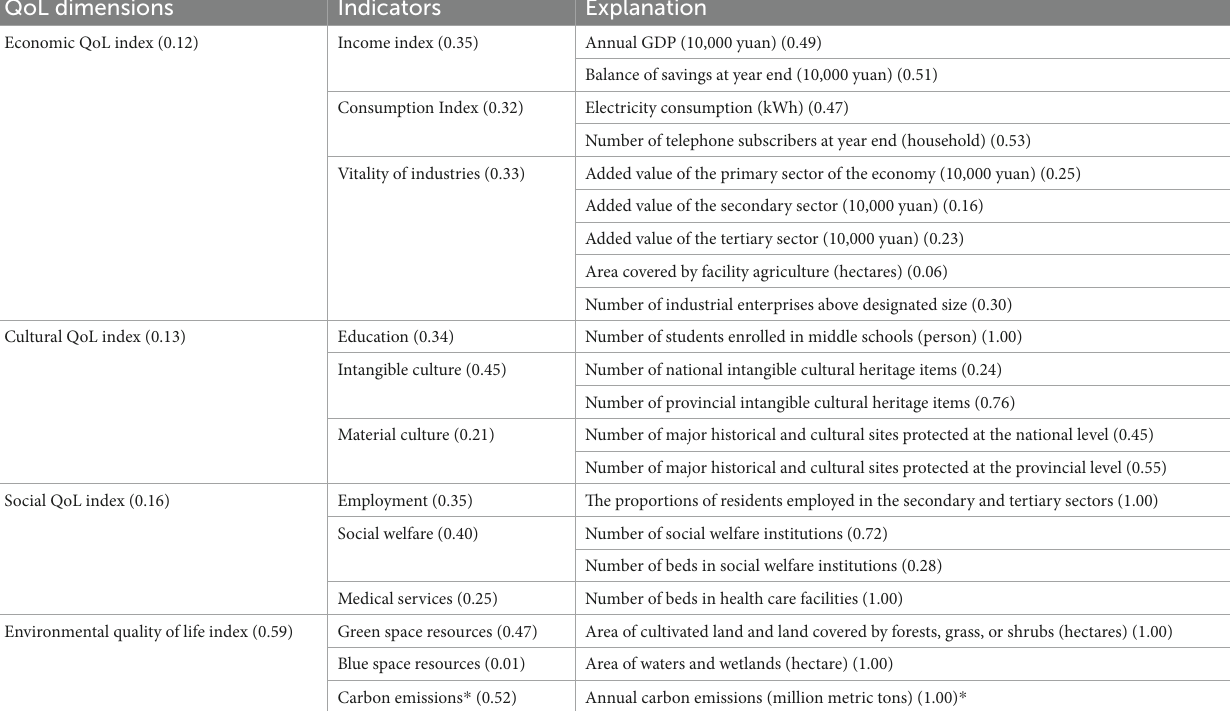
TABLE 1 QoL assessment index system and weights